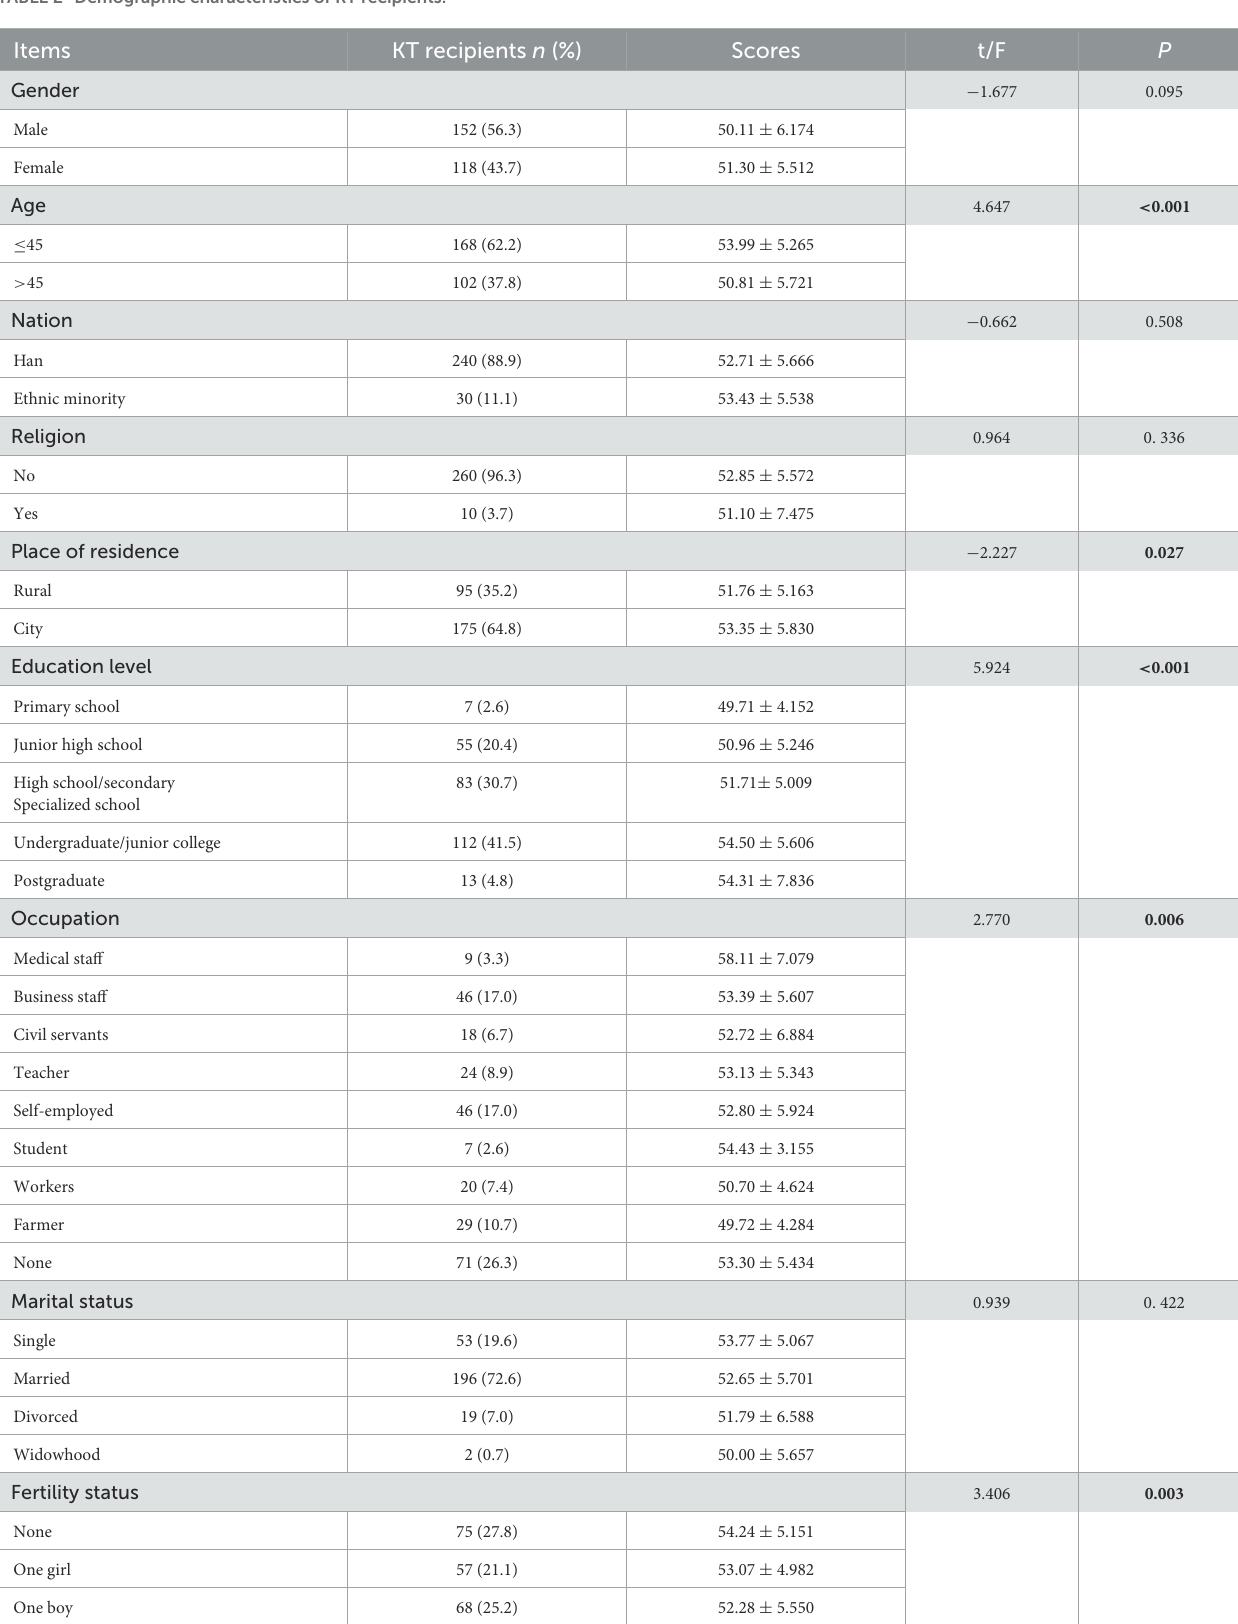
TABLE 2 Demographic characteristics of KT